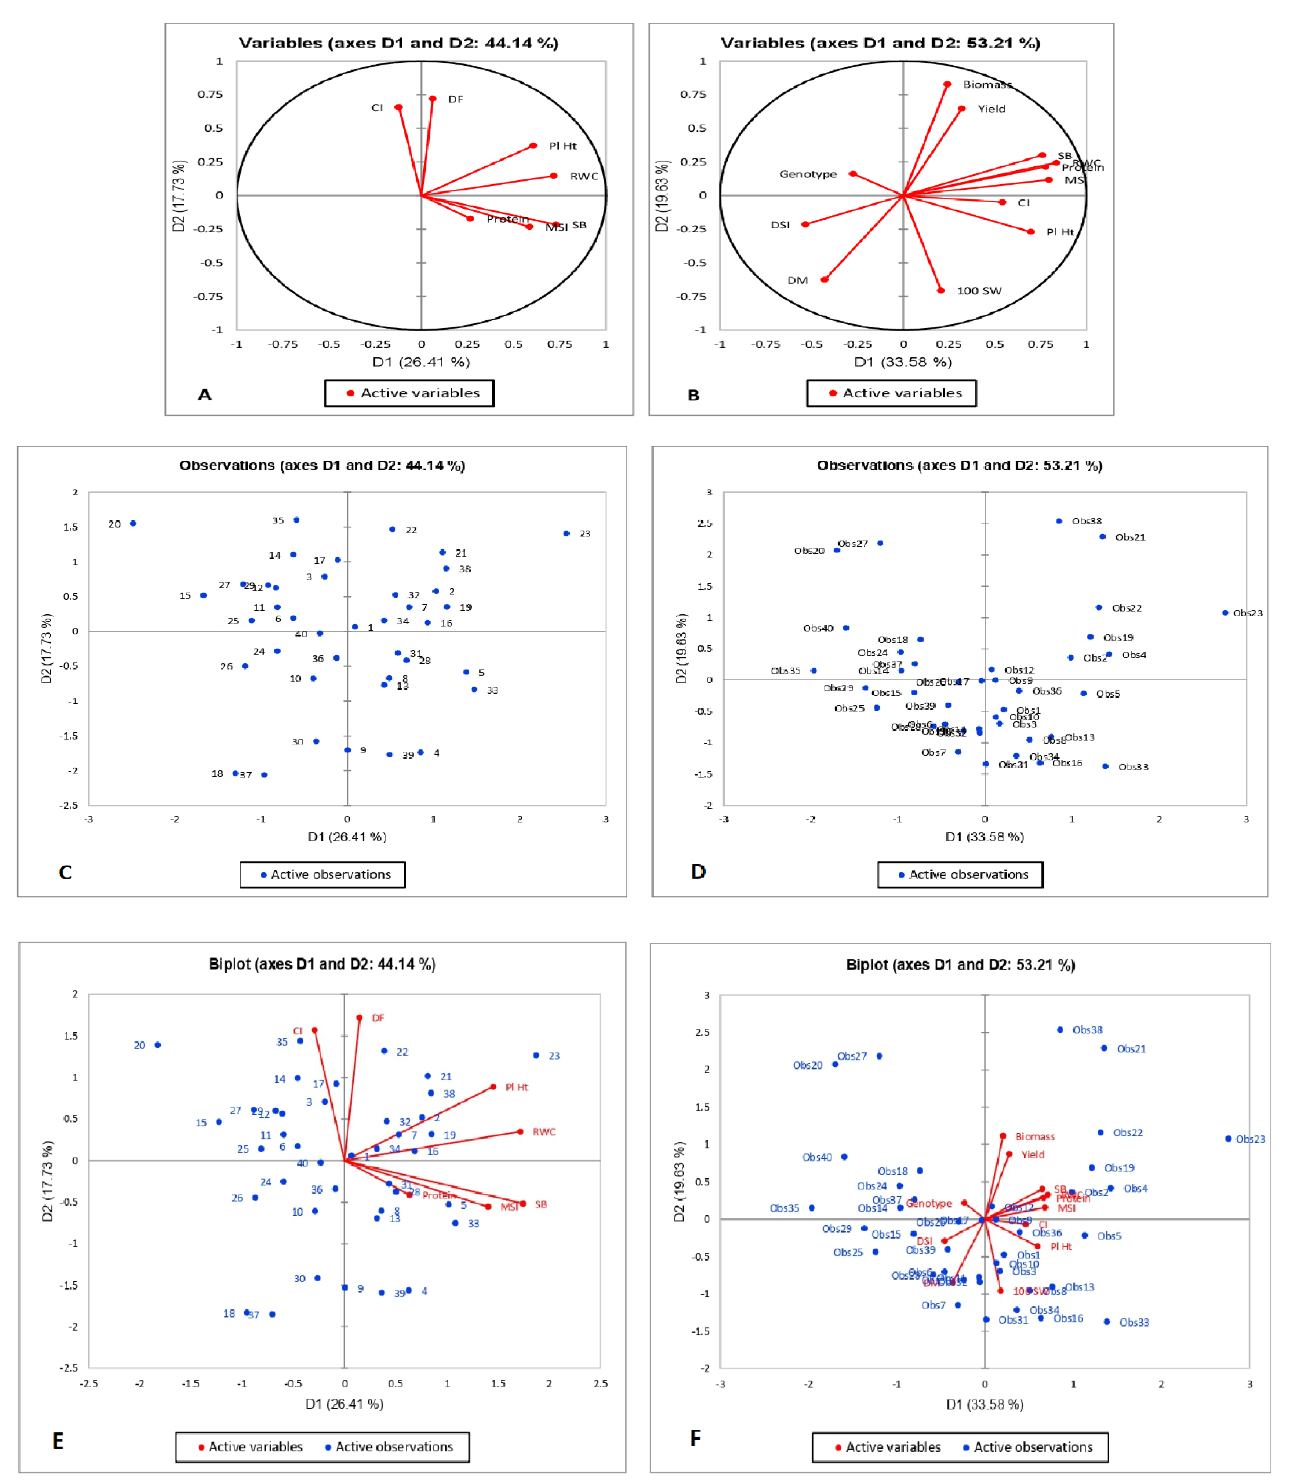
Figure 4. PCA biplots depicting relationships between the traits measured at vegetative stage ( A ), reproductive stage ( B ); Distribution of 40 chickpea genotypes based on principle component analy- sis under stressed conditions at vegetative stage ( C ), reproductive stage ( D ); PCA-based biplots de- picting performance of 10 most drought-tolerant chickpea genotypes under stressed conditions at vegetative stage ( E ) and reproductive stage ( F ), where Pl Ht, RWC, MSI, CI, DF, SB, 100 SW, DM, DSI indicate the plant height, relative water content, membrane stability index, chlorophyll index, days to flowering, secondary branches, 100 seed weight and days to maturity and drought